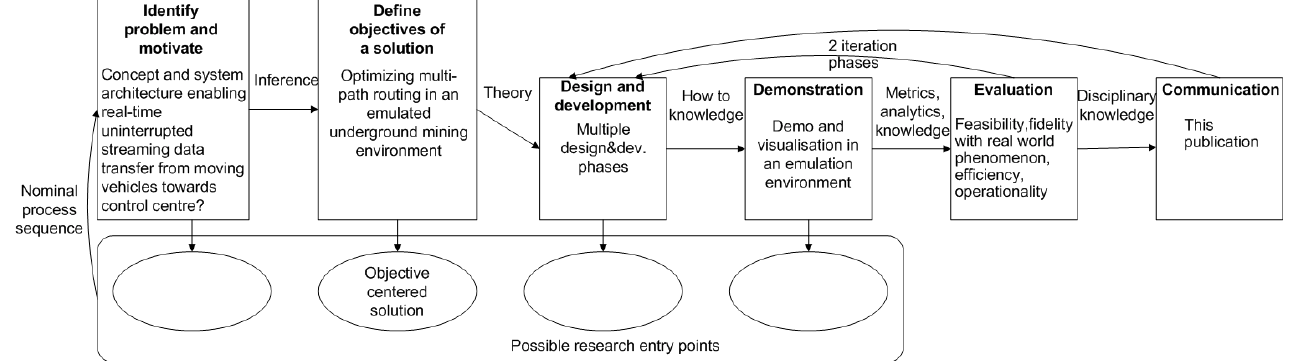
Figure 1. The research process performed based on the DSR methodology (figure is adapted based on [18]). on